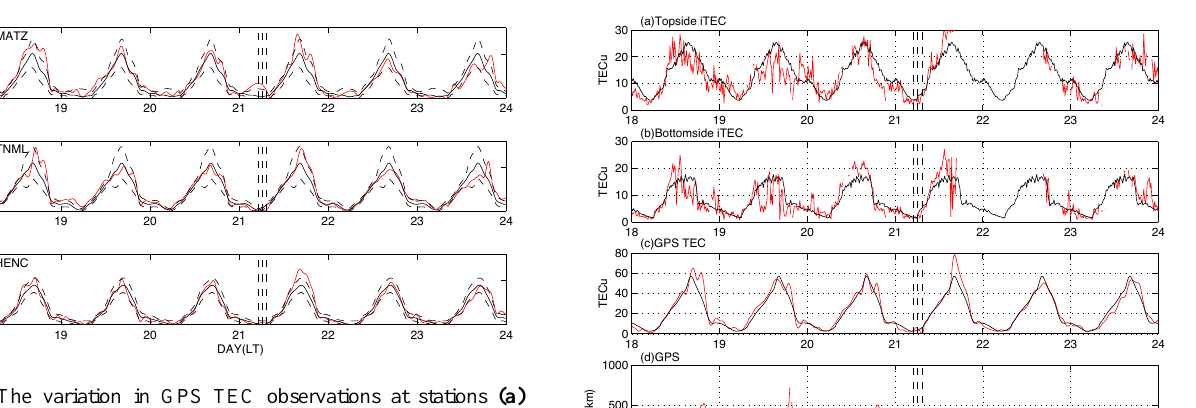
Fig. 5. The variation in GPS TEC observations at stations (a) MATZ, (b) TNML, and (c) HENC from 18 to 23 May 2012. The red, solid, and dashed lines denote the observed, monthly mean, and error bar values, respectively. The vertical dashed lines show the on- set, second contact, and ending time of the annular solar eclipse over Taiwan.